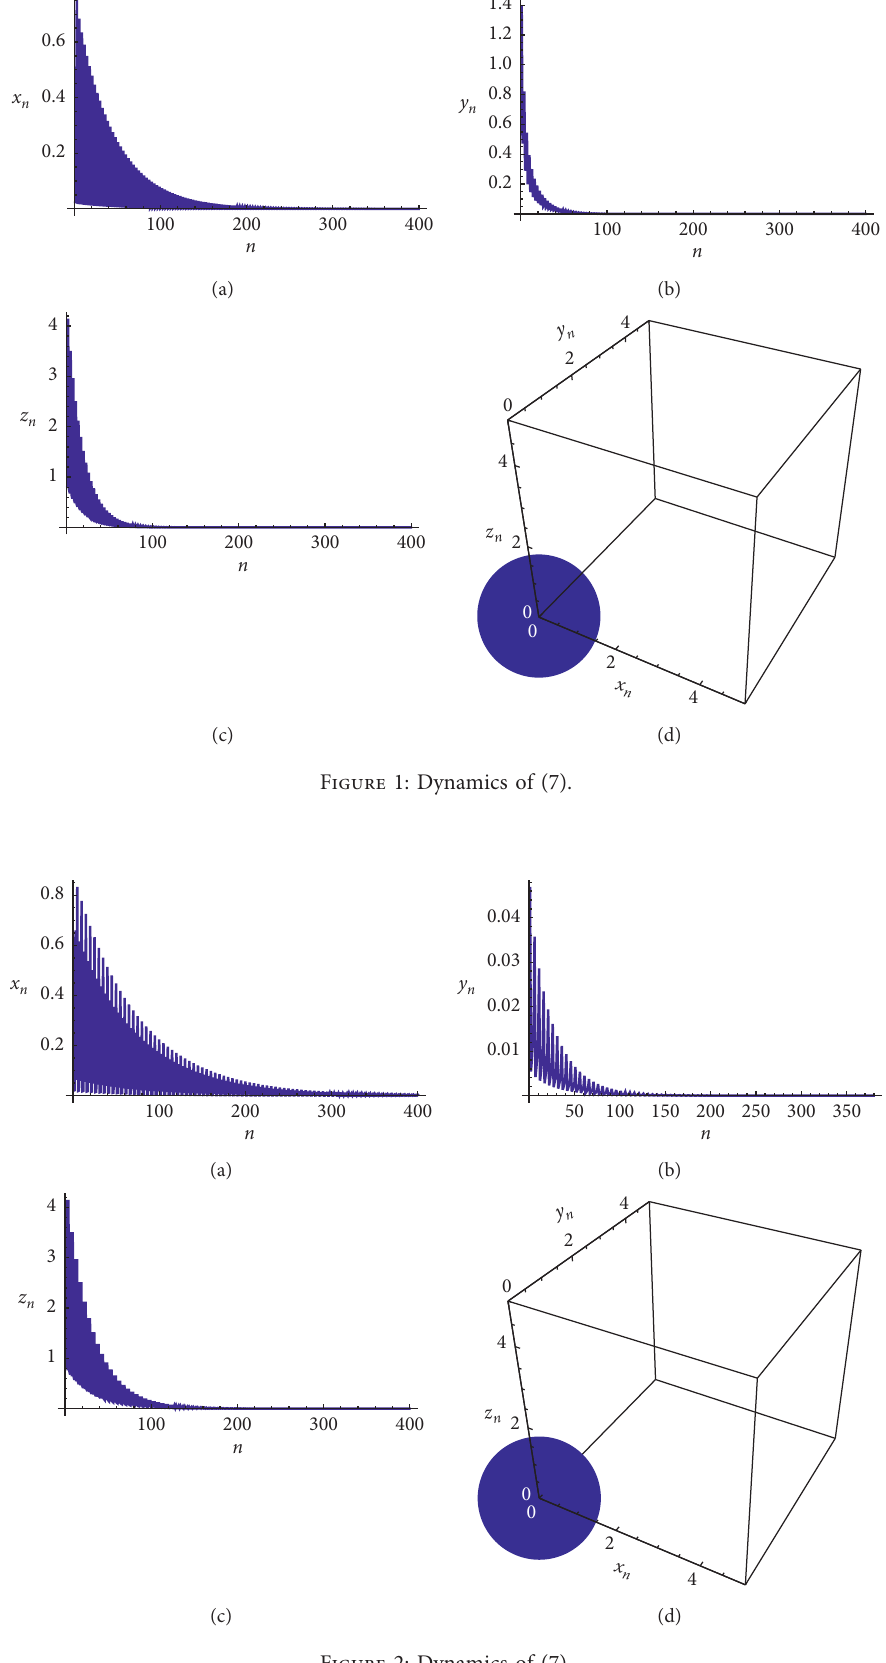
Figure 2: Dynamics of